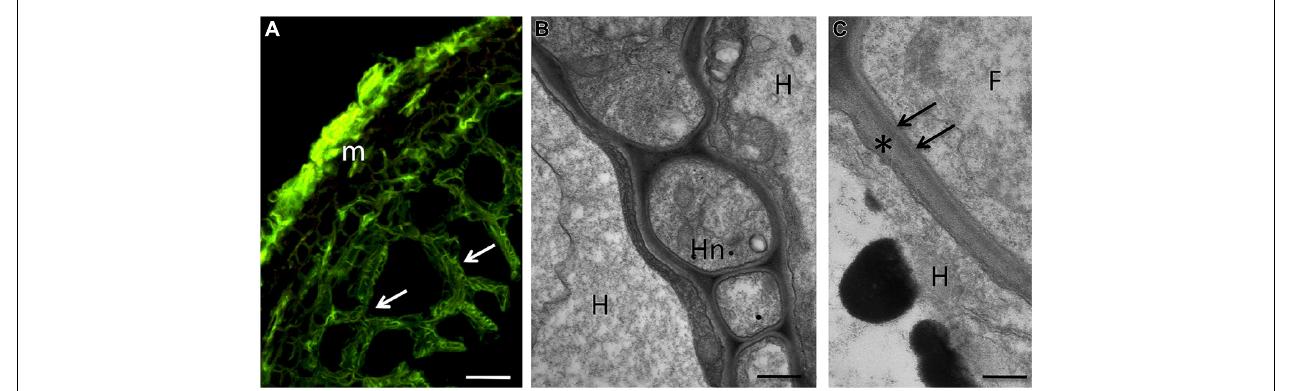
showing a section of hazelnut – Tuber melanosporum ectomycorrhizal root. The mantle (m), formed by packed hyphae, and the Hartig net (arrows), which surrounds the epidermal and outer cortical cells, show a green signal after treatment withWGA-FITC. Bar, 15 μ m. (B) Hartig net (Hn) in a fully truffle developed mycorrhiza. Hyphae develop among plant cells, and their cell walls are in direct contact with the plant cell walls, showing a simple interface structure. H, host cell; Hn, Hartig net. Bar, 0.6 μ m. (C) Magnification of the contact zone between plant (asterisk) and fungal cell wall (arrows). F, fungus; H, host cell. Bar, 0.4 μ